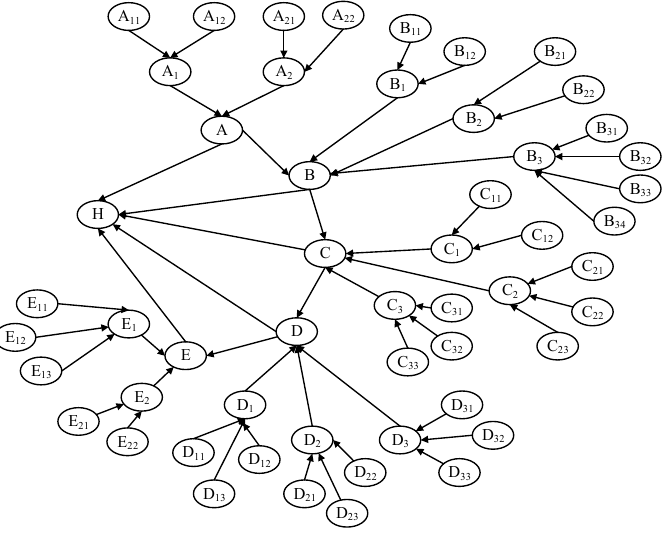
Figure 4. BN structure of prefabricated building hoisting construction.